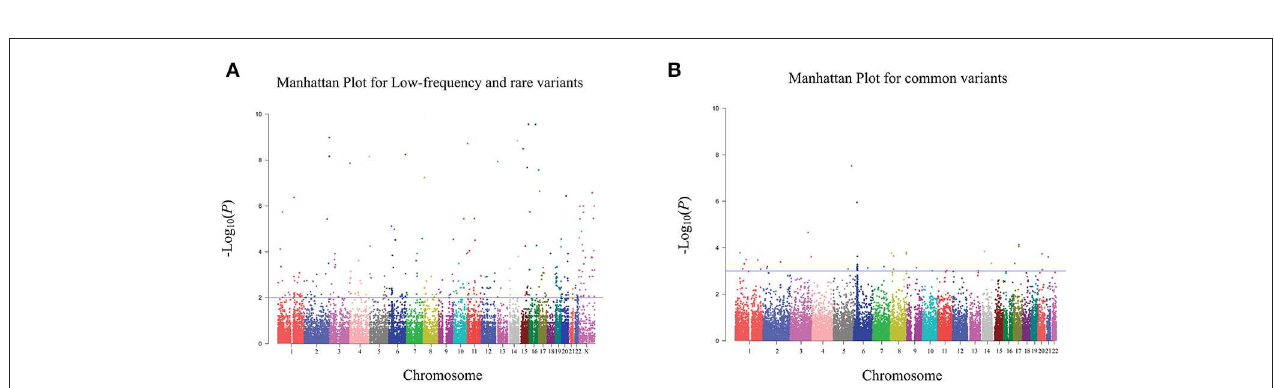
FIGURE 2 | Manhattan plot for exome chip of bladder cancer in Han Chinese populations in the discovery stage. (A) Manhattan plot for low-frequency and rare variants. (B) Manhattan plot for common variants. The X axis represents the chromosomal position and the Y axis represents the –log 10 P -value. The blue line indicates the filtering threshold of –log 10 P -value. For low-frequency and rare variants, the blue line represented 0.01. For common variants, the blue line represented 0.001.